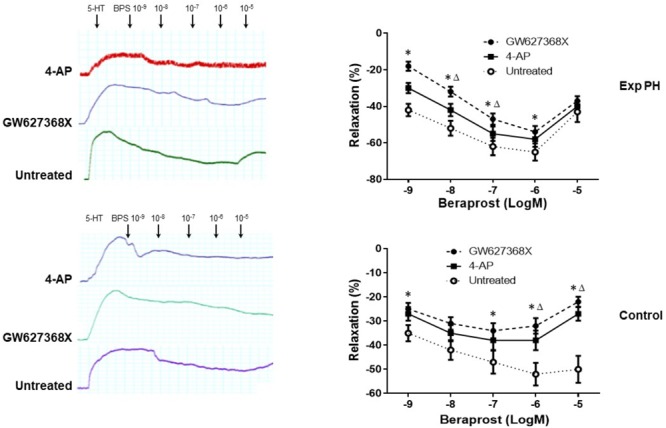
Dilatory responses in pulmonary artery rings to Beraprost in the presence or absence of the Kv channel antagonist 4-AP or the EP4 antagonist GW 627368X in rats with (n = 10) and without Experimental PH (n = 10). Results are mean ± SEM. ∗p < 0.05 Presence vs. absence of GW27368X. Δp < 0.05 GW27368X vs. 4-AP.